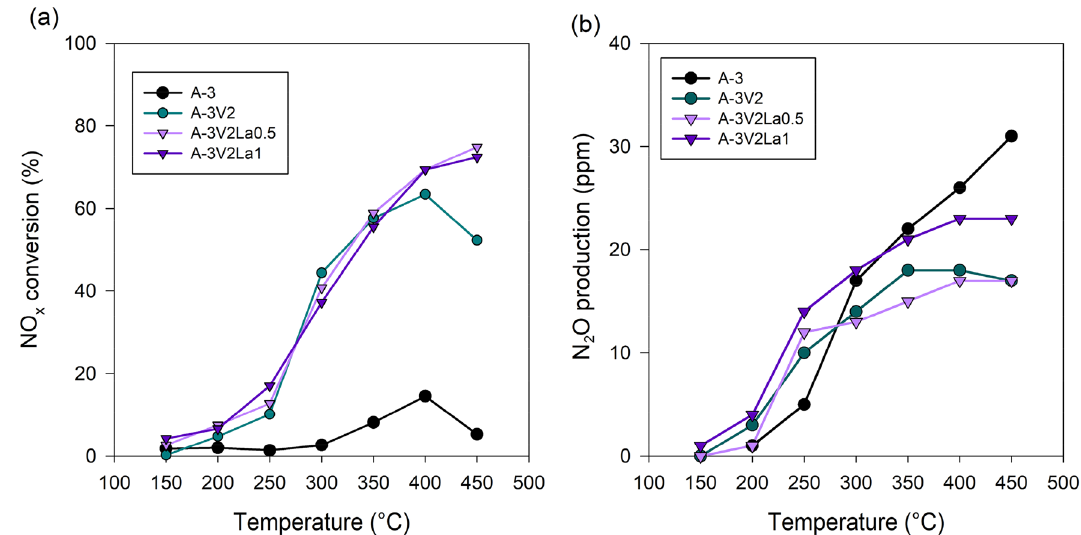
Figure 5. Results of catalytic tests using the selected materials, including NO x conversion ( a ) and by-product (N 2 O) production ( b